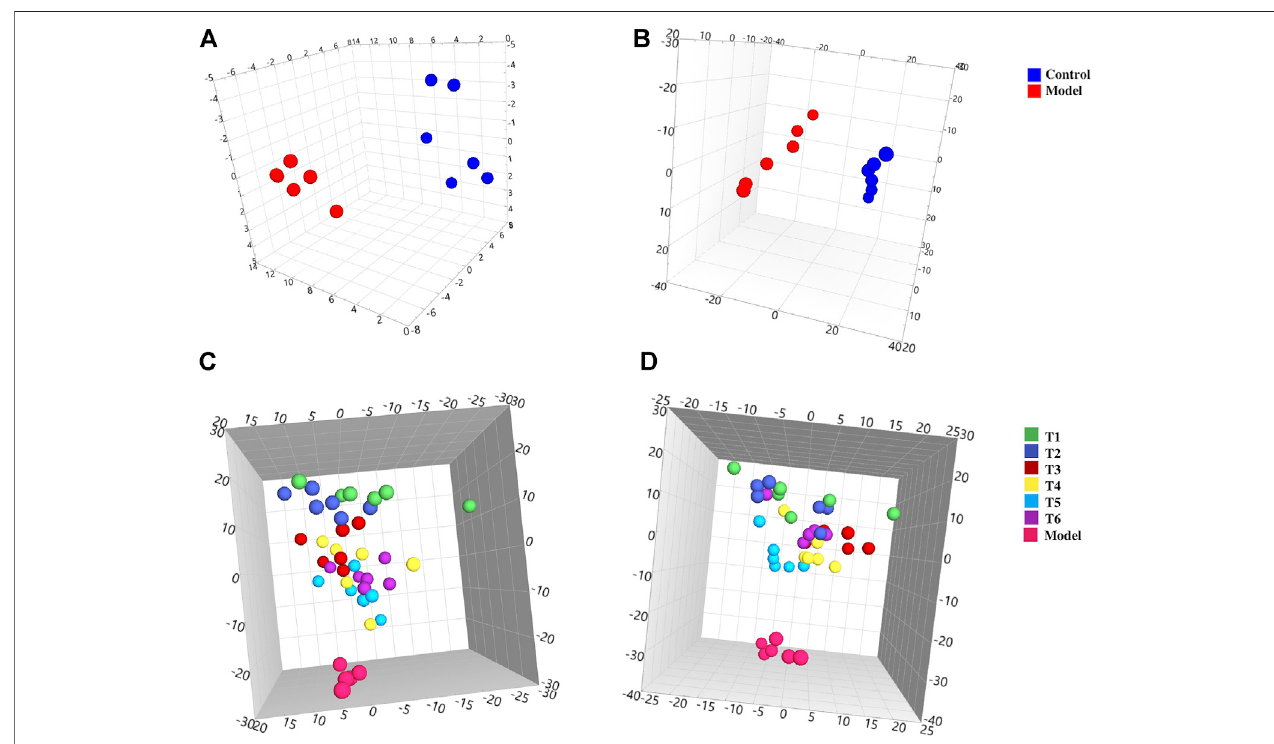
FIGURE 2 | 3D PCA score plots of the plasma samples from different groups. Control and model groups: (A) ESI + , R 2 X = 0.796, Q 2 = 0.754 and (B) ESI − , R 2 X = 0.920, Q 2 = 0.838; model and treatment groups: (C) ESI + , R 2 X = 0.730, Q 2 = 0.559 and (D) ESI − , R 2 X = 0.752, Q 2 = 0.552.